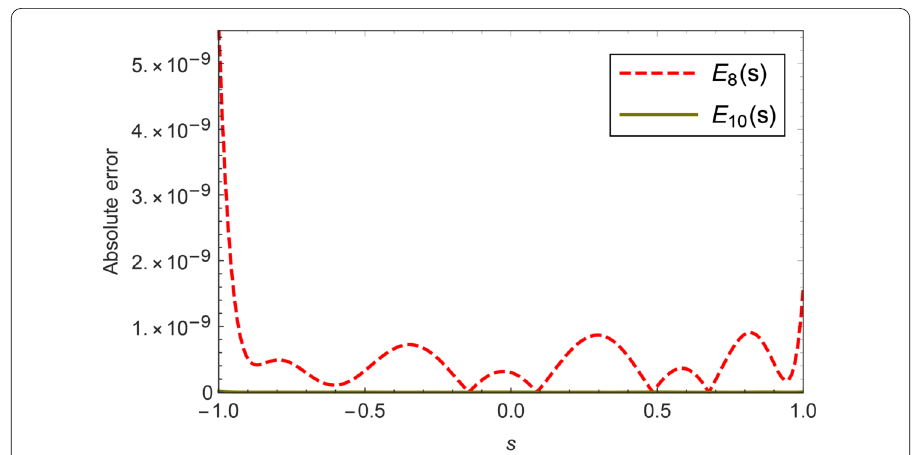
Figure 6 Absolute errors | E n ( s ) | for Example 3 with m = 10